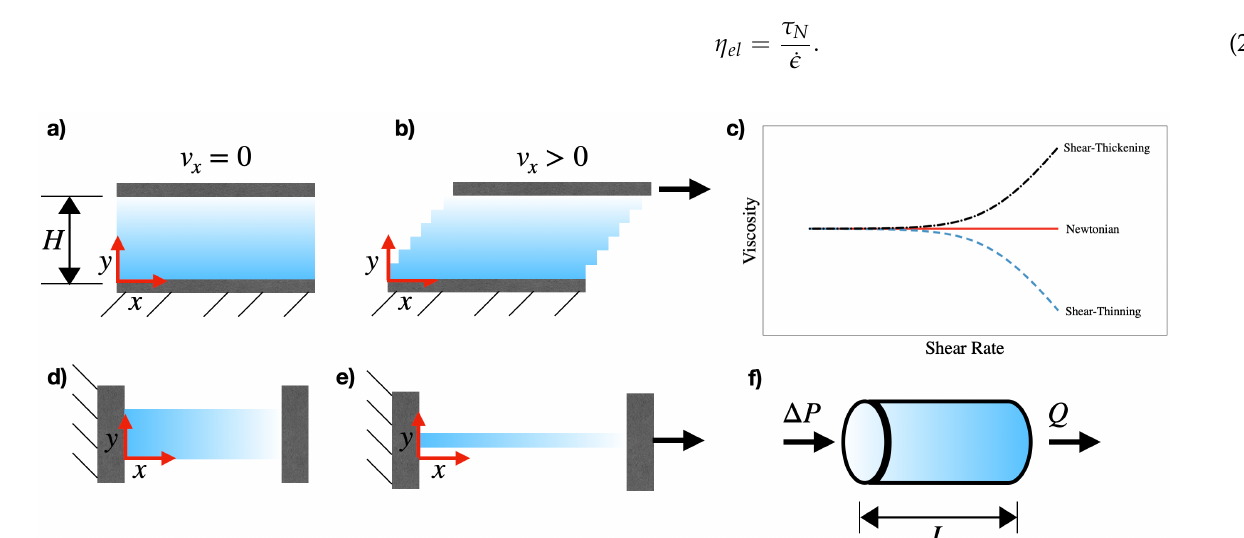
Figure 1. ( a ) Fluid between two parallel plates in stationary conditions. ( b ) A force is applied to the upper plate, leading to a shear flow along the y -direction. ( c ) Examples of Newtonian liquids with viscosity independent of the shear rate (solid red line), shear-thinning liquids having viscosity that decreases when increasing the shear rate (dashed blue line) and shear-thickening liquids having viscosity that increases when increasing the shear rate (dot-dashed black line). ( d ) Fluid between two parallel plates arranged horizontally in stationary conditions. ( e ) A force is applied to the plate on the left, thus leading to an extensional flow along the x -direction. ( f ) Schematic of the flow in a cylindrical channel, encountered in capillary